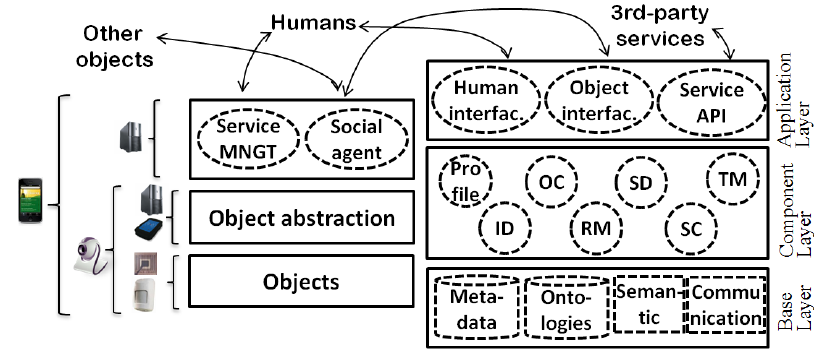
Figure 11. Architecture for SIoT: client side (left) and server side (right) (see [64]).